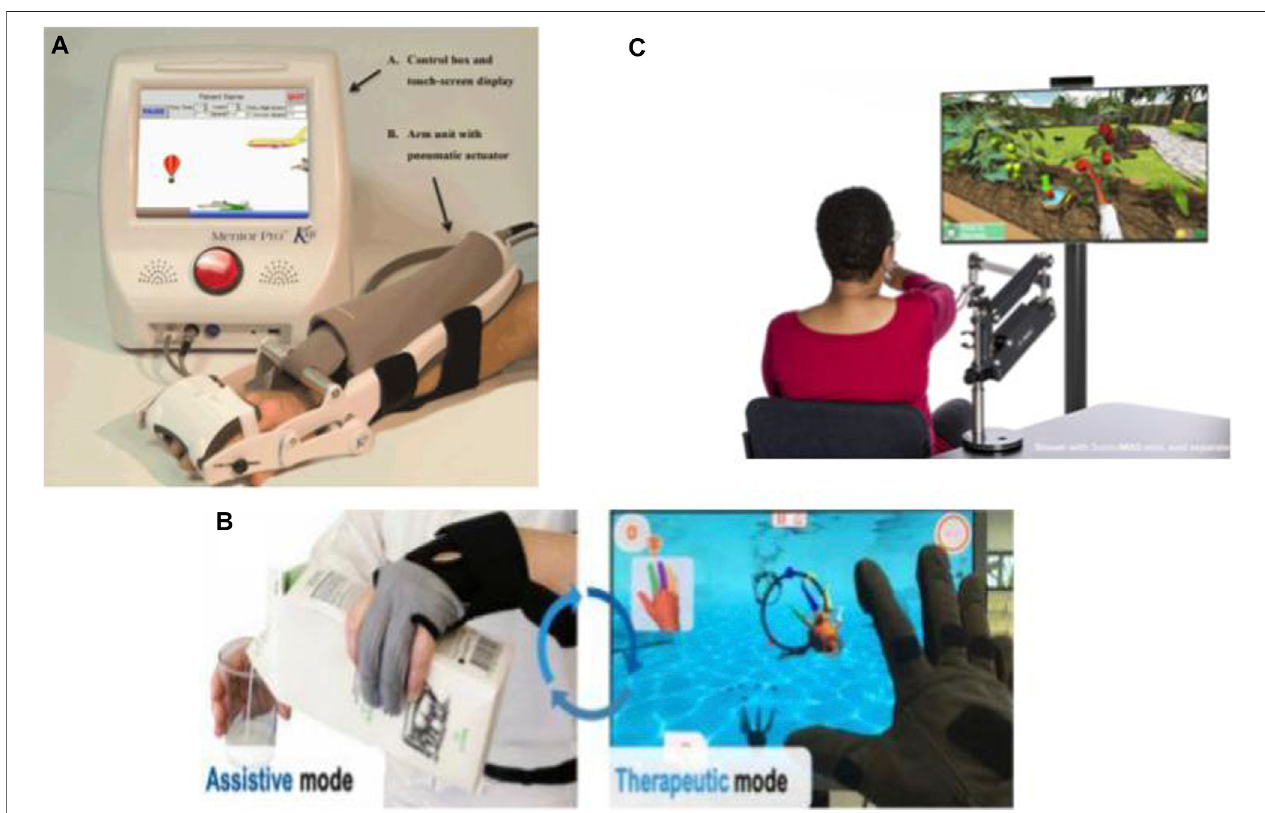
FIGURE3| Commercializedroboticdevicesforhome-basedupper-limbrehabilitation: (A) TheMotusHand(Butleretal.,2014), (B) IronHand(Radderetal.,2019), and (C) SaeboVR (Recover From Your Stroke With Saebo 2017).